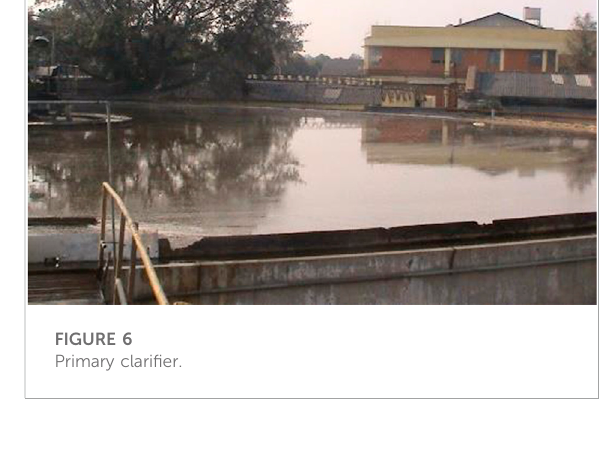
FIGURE 9 Secondary clari fi